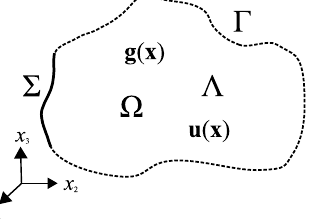
Fig. 1. The vibro-acoustic displacement u ( x ) and the body force g ( x ) in the domain Ω where Σ = ∂ Ω \ Γ , and Λ = Ω ∪ Γ . x = [ x 1 ; x 2 ; x 3 ] is the position in space.